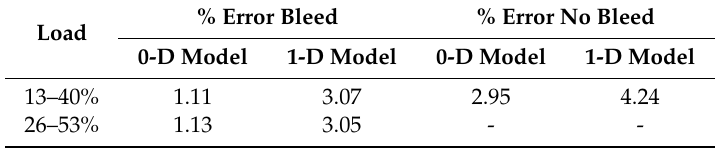
Table 1. Average error in simulated compressor discharge pressure from 0-D and 1-D compressor models.